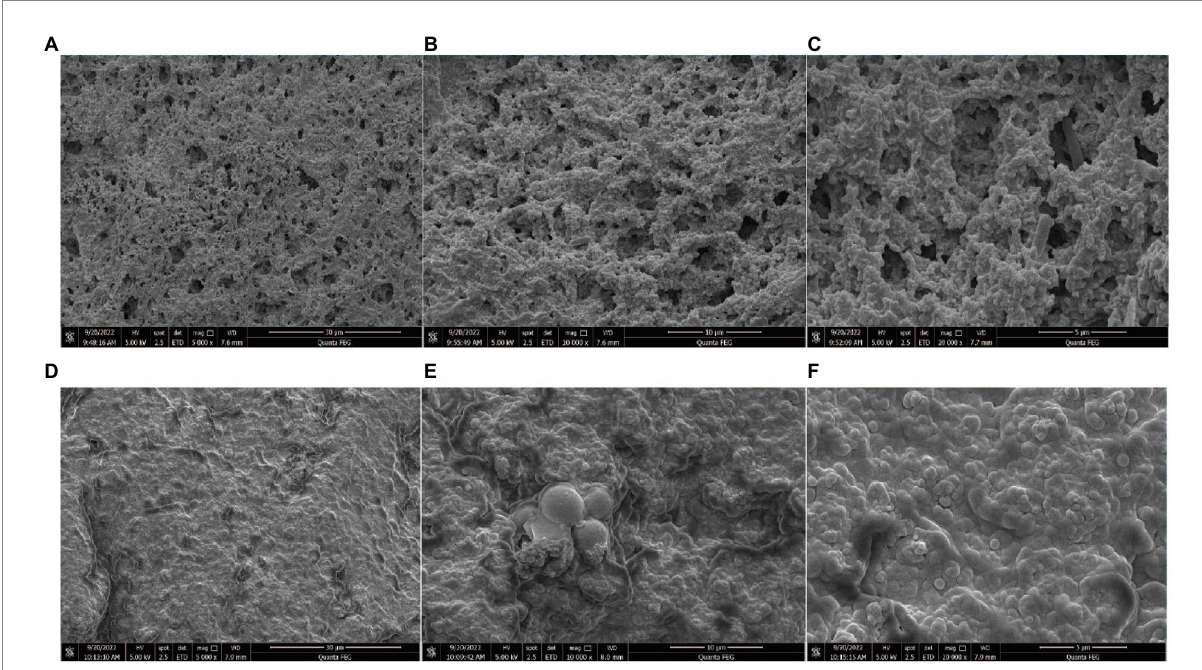
FIGURE 4 The SEM micrographs of yogurt L 1 and kefir at different magnifications ( A,B,C represents L 1 yogurt magnification of 5.00 k×, 10.00 k×, and 20.00 k×. D,E,F represents kefir magnification of 5.00 k×, 10.00 k×, and 20.00